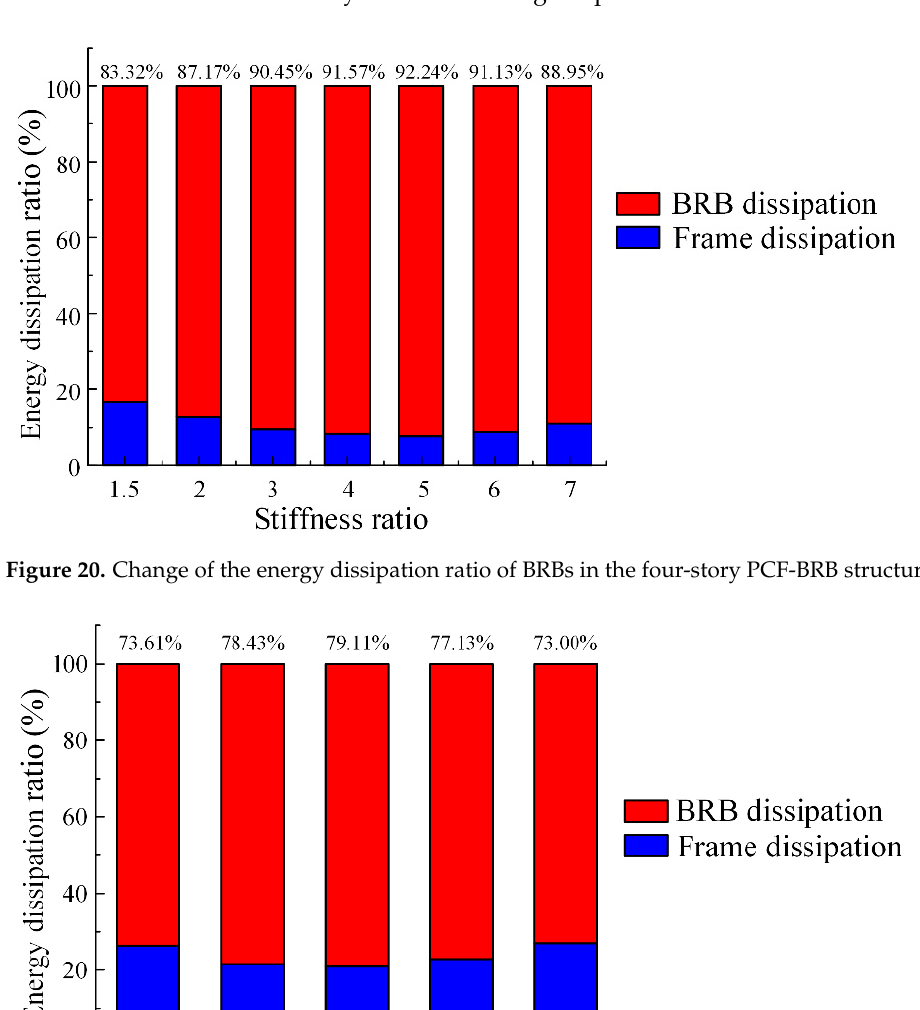
( b ) Figure 19. Average maximum inter-story drift of the 12-story PCF-BRB structure: ( a ) changes and ( b ) average ratio. 5.2. Energy Dissipation Ratio of BRBs In the 4-story PCF-BRB structure, the change of the energy dissipation ratio of BRBs